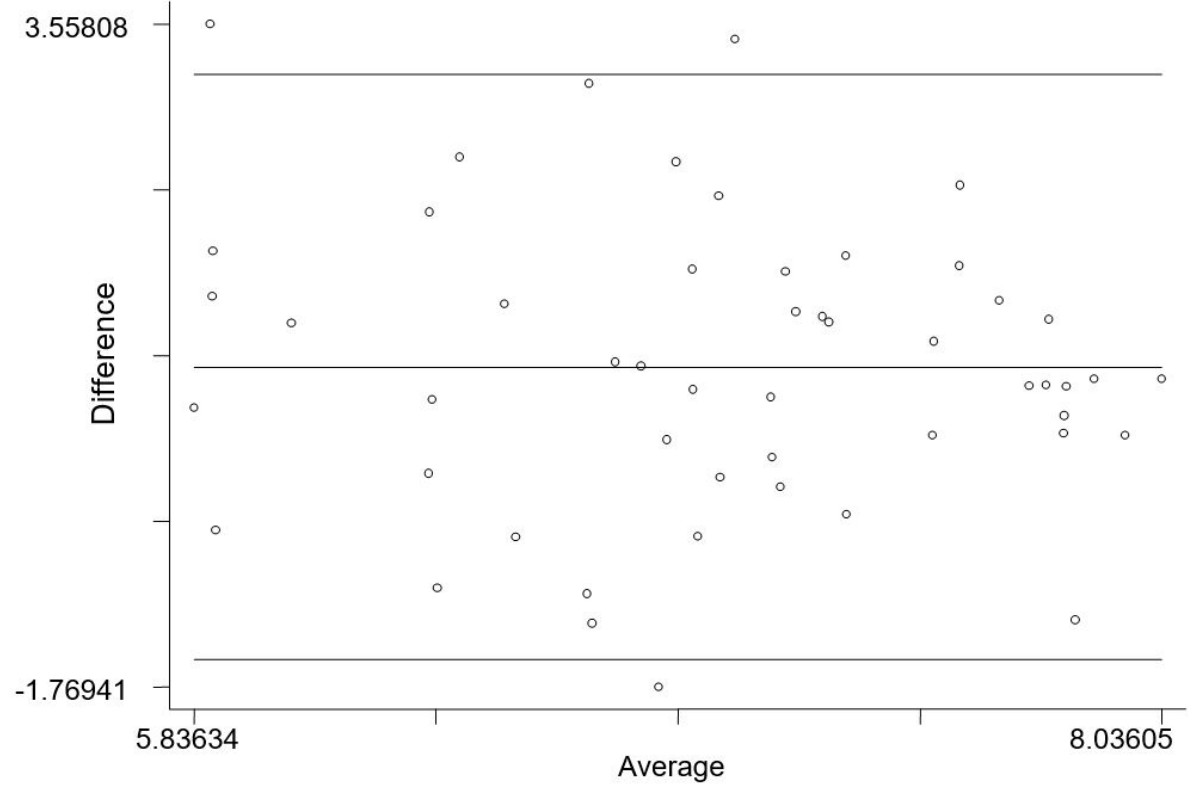
Figure 3. Bland-Altman plot of natural log transformed score showing the difference between MAAS and SWA, plotted against the mean. Note: the lines represent the limits of agreement (95%) and average difference between the two